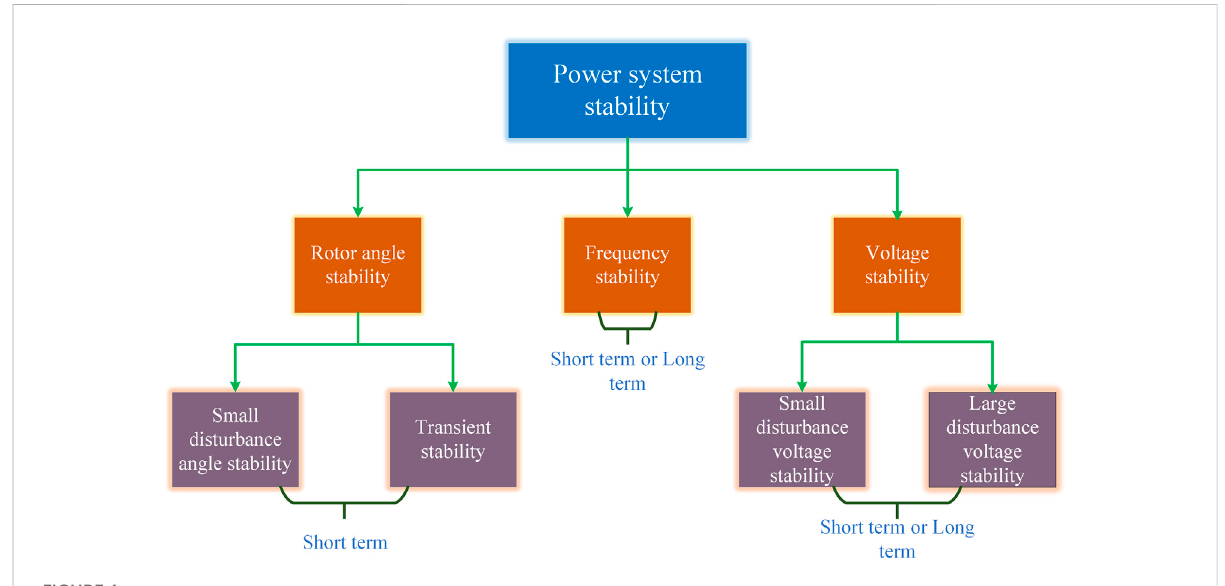
FIGURE 1 Different types of stabilities in power